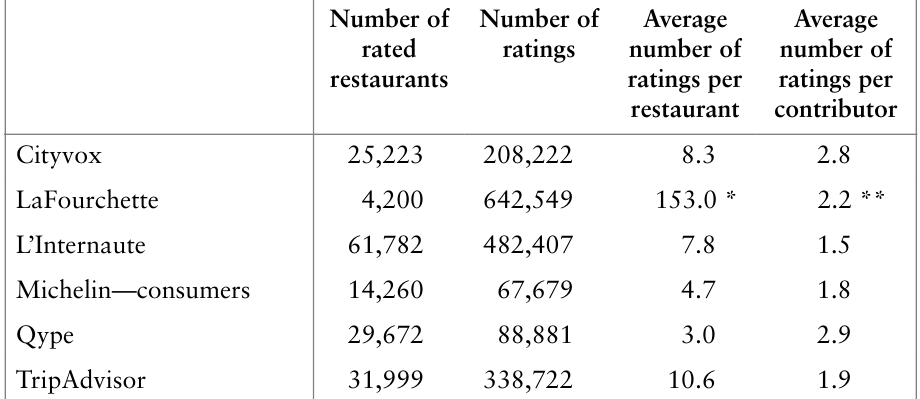
Table 5. Average rating activity.